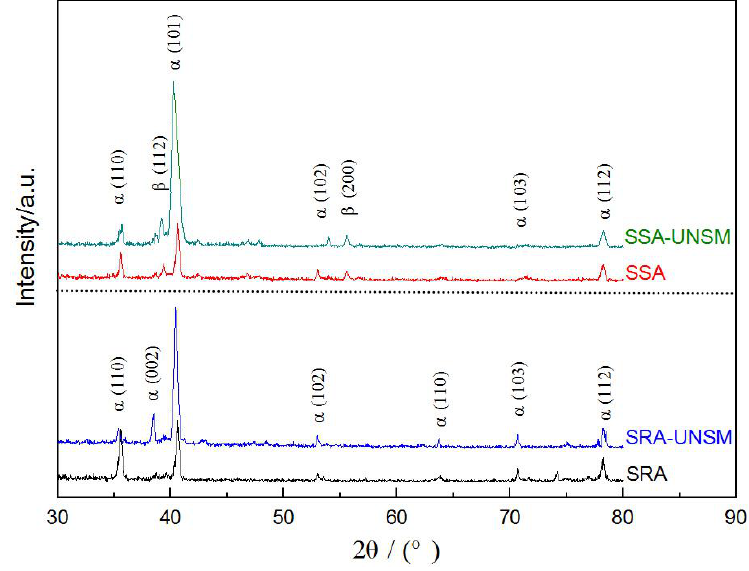
Figure 3. XRD patterns of Ti6Al4V.